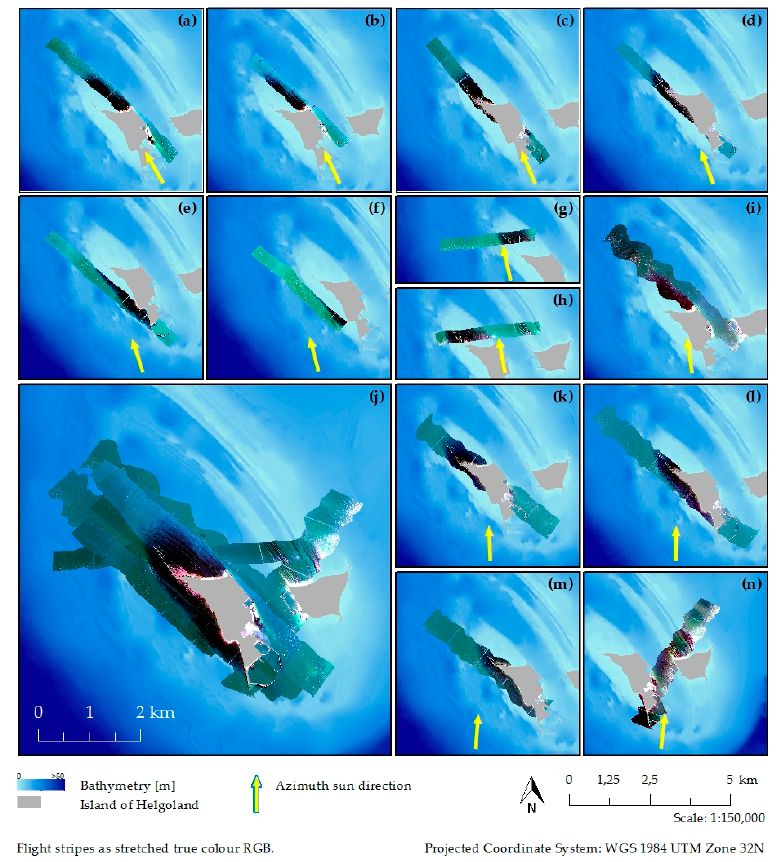
Figure A1. ( a ) Stretched true colour images of all flight stripes and azimuth sun direction during data acquisition ( a ) FS 1 ( b ) FS 2 ( c ) FS 3 ( d ) FS 4 ( e ) FS 5 ( f ) FS 6 ( g ) FS 7 ( h ) FS 8 ( i ) FS 9 ( j ) mosaic of all FS ( k ) FS 10 ( l ) FS 11 ( m ) FS 12 ( n ) FS 13.